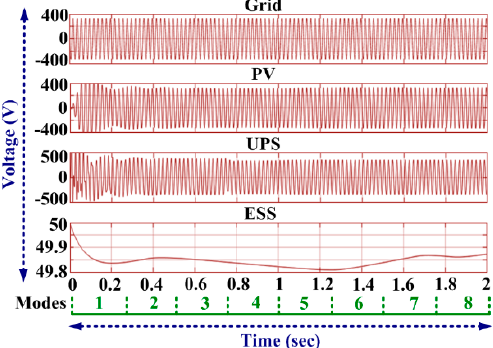
Figure 7. Output voltage of (top to bottom: grid, PV, UPS, and ESS).